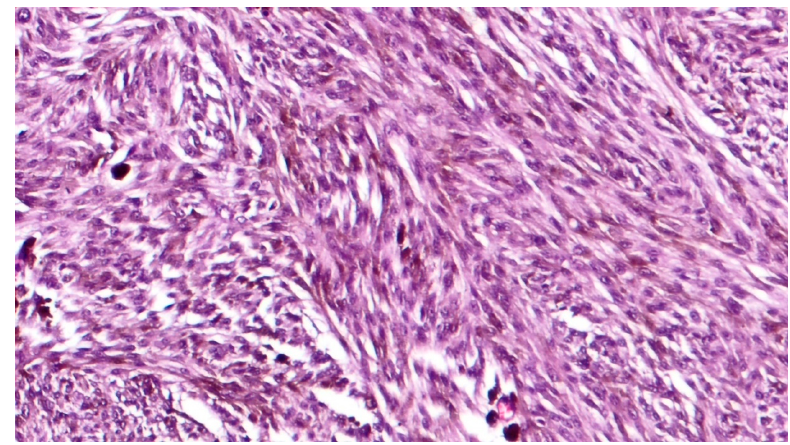
Figure 2. High magnification showing spindle cell type, pigmented, choroidal melanoma, composed of a mixture of spindle A and B cells (hematoxylin and eosin; original magnification 200×).